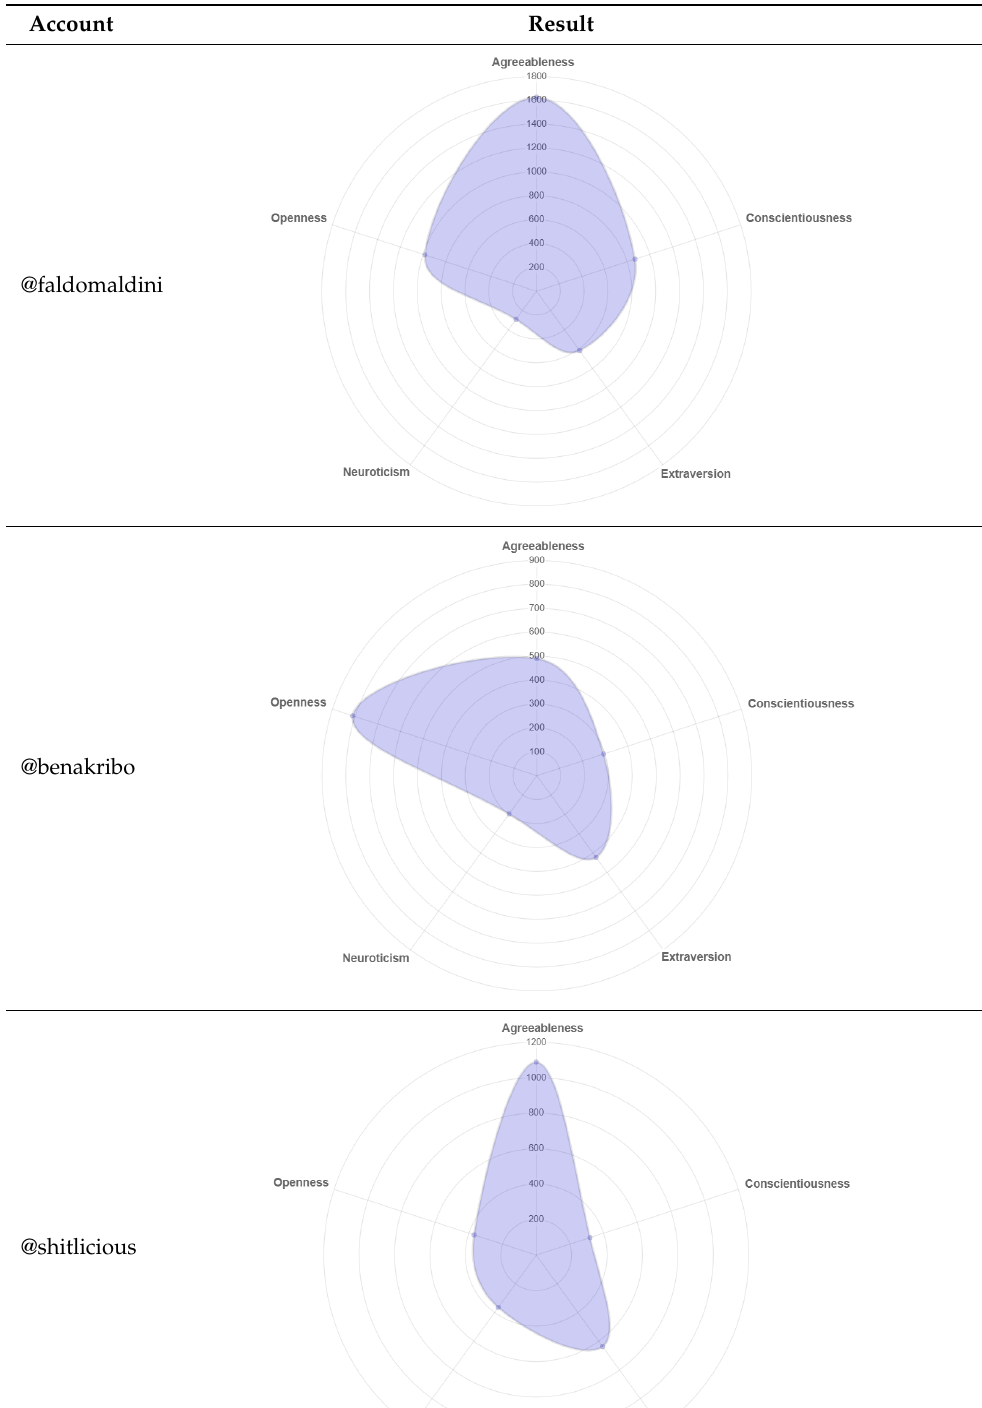
Figure 6. ( a ) The platform interface, ( b ) The interface for voting mechanism in crowdsourcing.